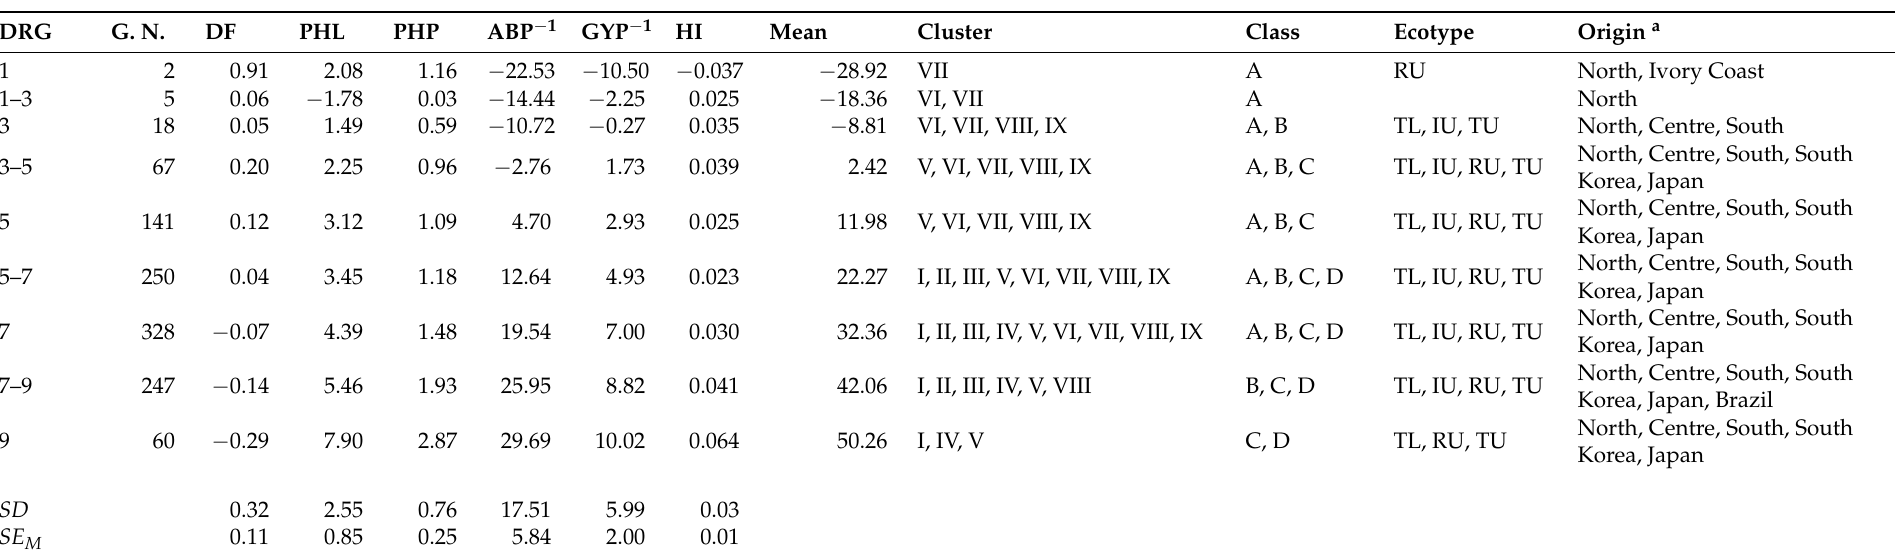
Table 7. Drought resistance grade (DRG), number of genotypes in each grade, mean of six traits under integrated relative drought stress susceptibility (RDS-I), mean of each grade, clusters, groups, ecotypes and origin of genotypes in each grade.